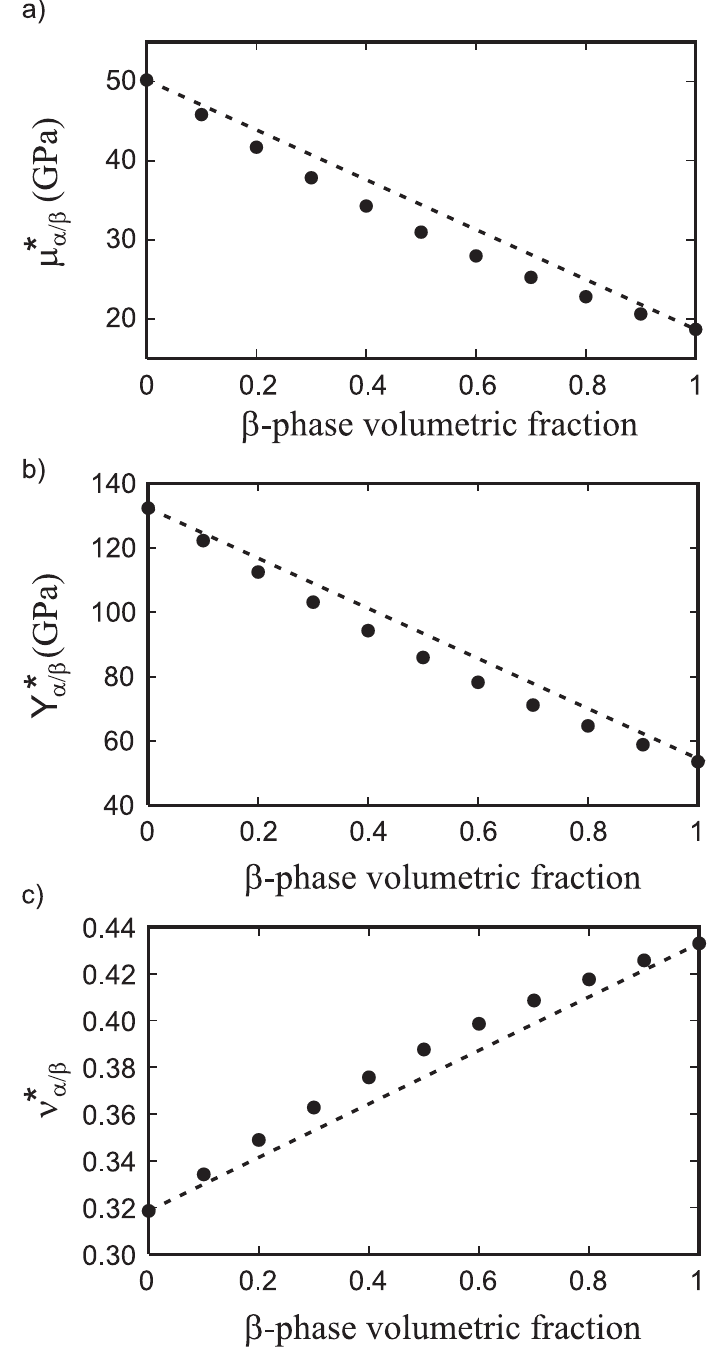
Figure 4. The theoretically predicted dependence of the ( a ) homogenized shear modulus µ ∗ ; ( b ) Young’s modulus Y ∗ ; and ( c ) Poisson’s ratio ν ∗ α/β of the Ti-Nb composite as a α/β α/β function of the volumetric β -phase content numerically determined with 0.1 compositional step. The values are compared with the values obtained from a linear interpolation (dashed lines) between the α and β